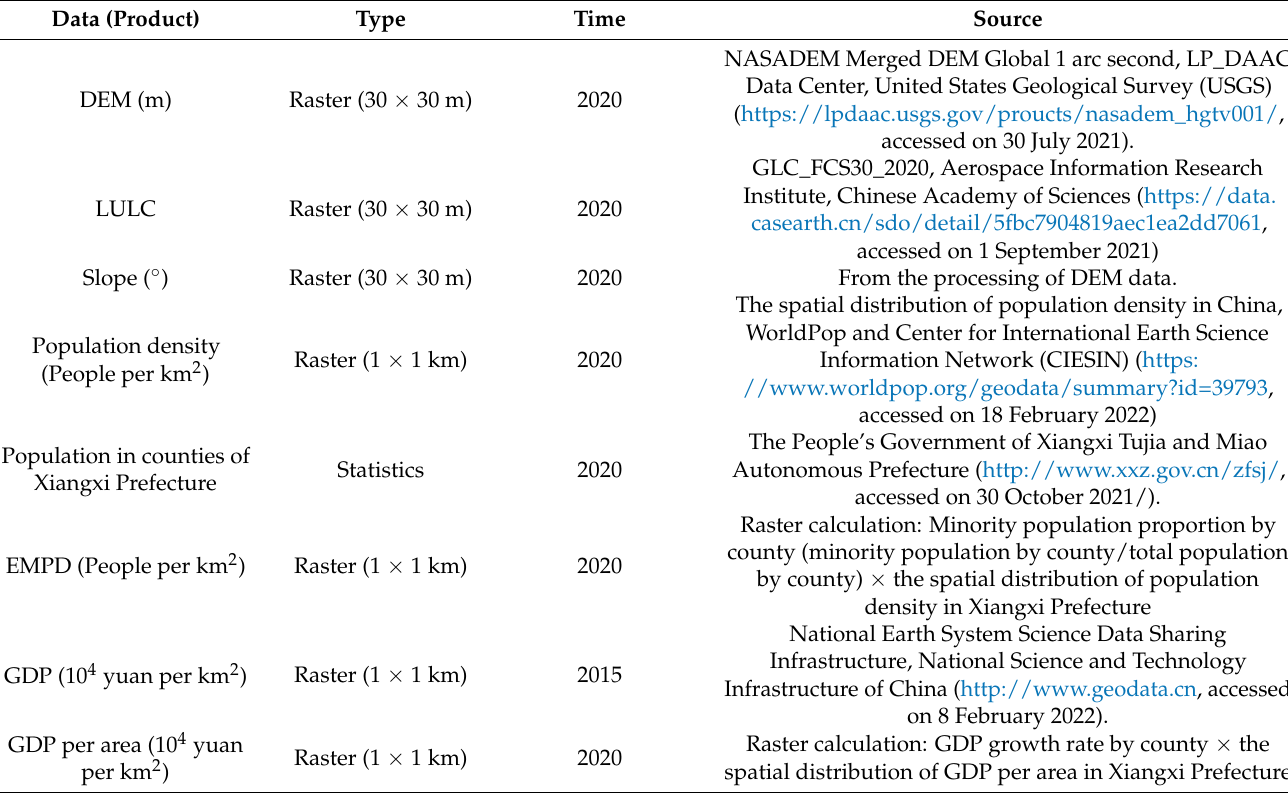
Table 1. Data information including type, time, acquisition, and processing.